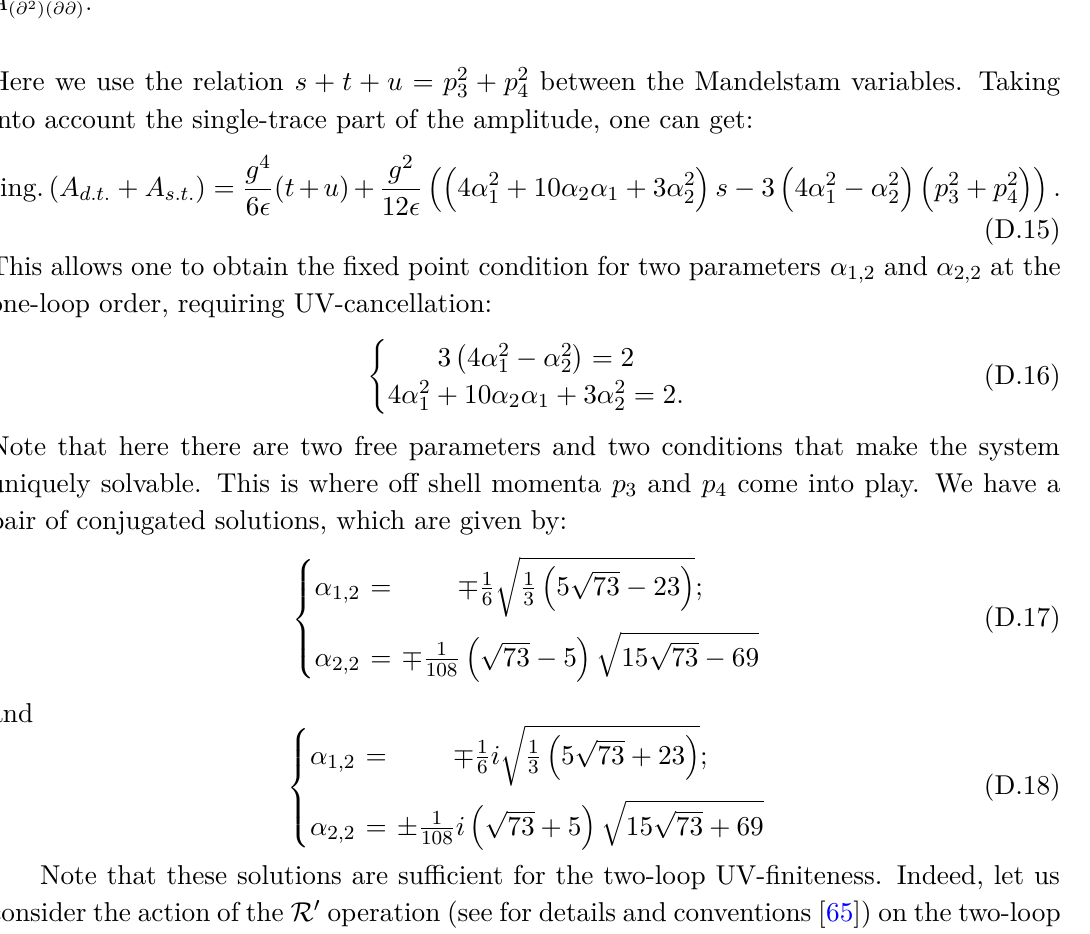
Figure 13 . Set of 1-loop integrals from the double-trace Lagrangian contributing to the amplitude A ( ∂ 2 )( ∂∂ )